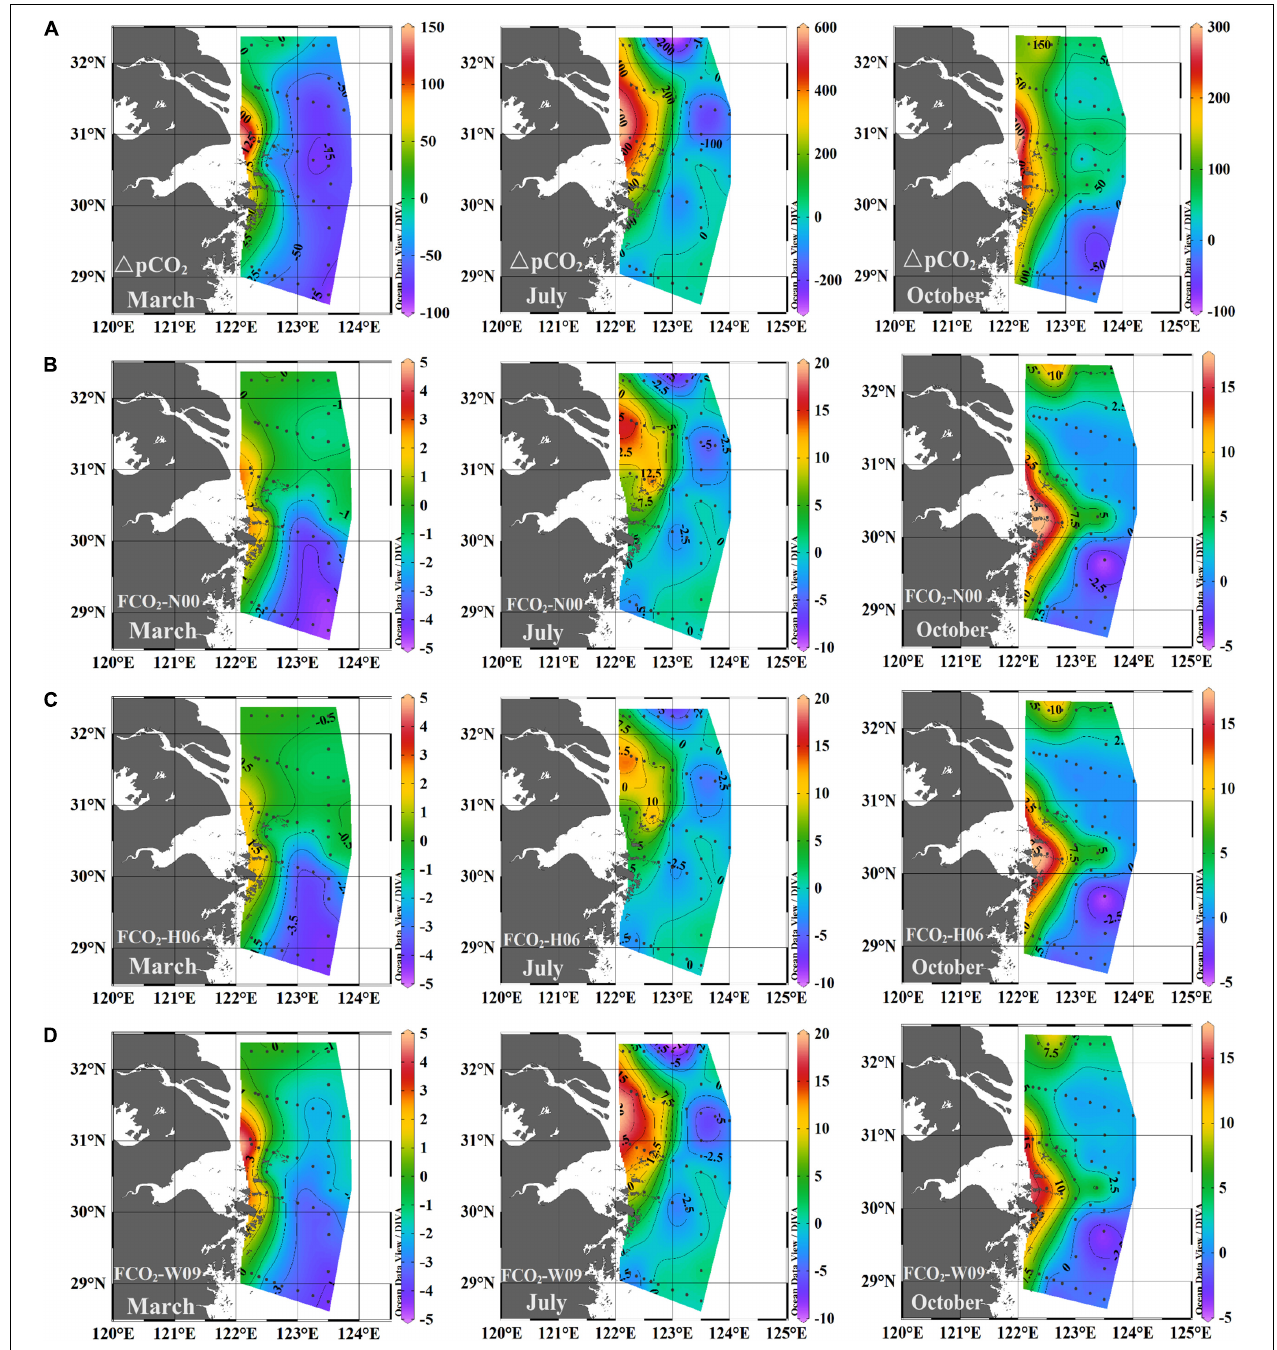
FIGURE 4 | Spatial distribution of (A) (cid:49) p CO 2 and F CO 2 (B, C, D) calculated using the respective k -wind speed relationships of N00, H06, and W09 in March, July, and October, 2018.